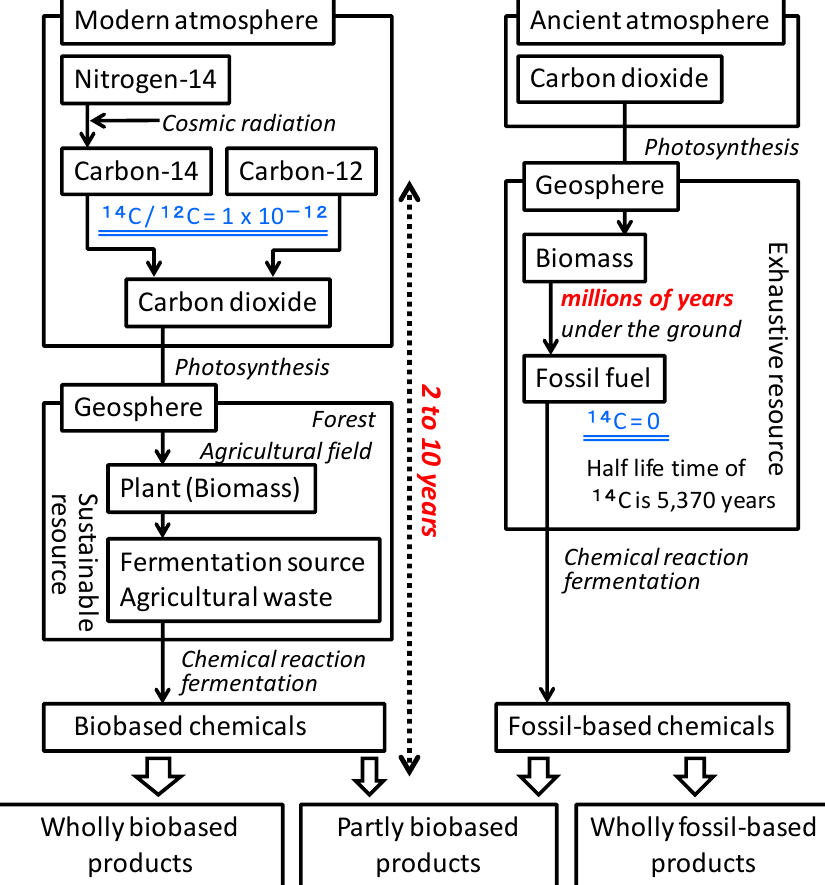
Figure 2. Mechanisms of 14 C insertion into biobased